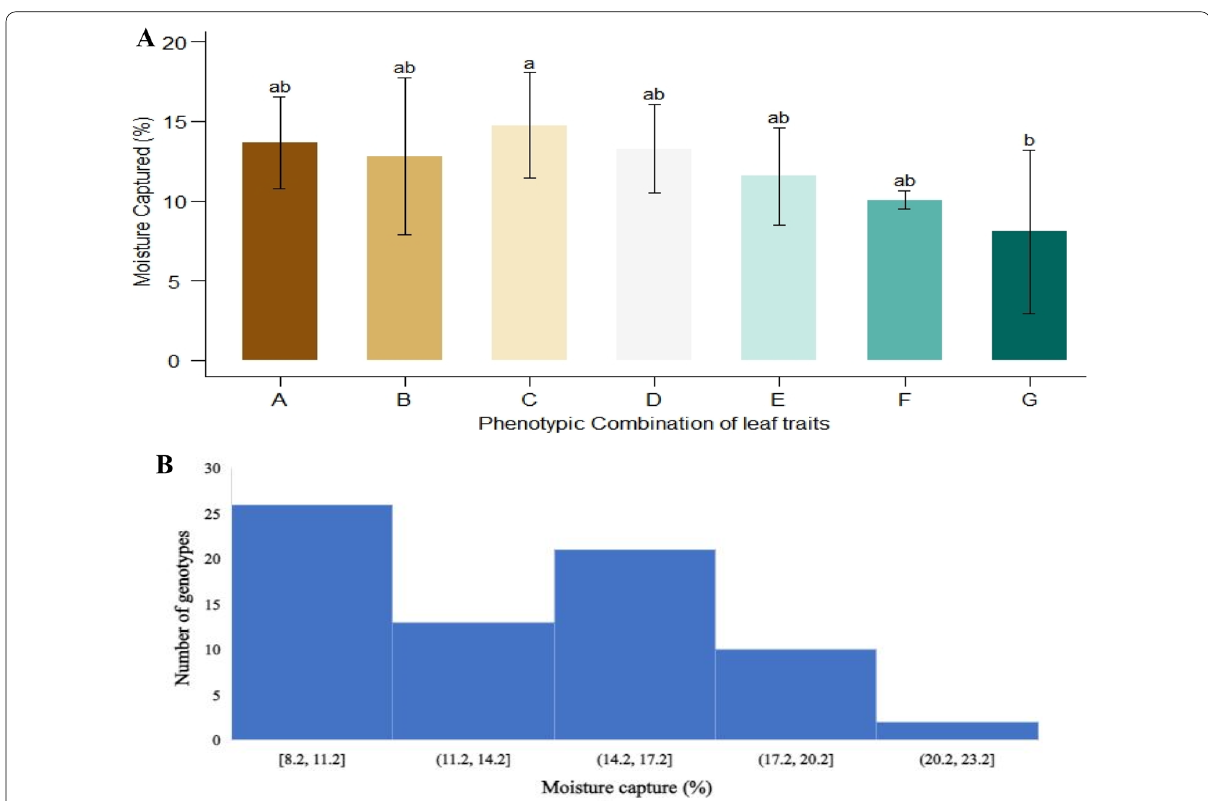
Fig. 4 The moisture capture (%) by phenotypic combinations i.e. A Inward and erect, B Inward, outward and erect, C Inward and semi‑erect, D Inward, outward and semi‑erect, E Inward and semi‑droopy, F Inward, outward and semi‑droopy and G Inward and droopy). Results are presented as mean and bar with the different letters are significantly different according to Tukey’s HSD of leaf traits (A). Histogram (B) shows the frequency of no. of genotypes into the each interval of moisture